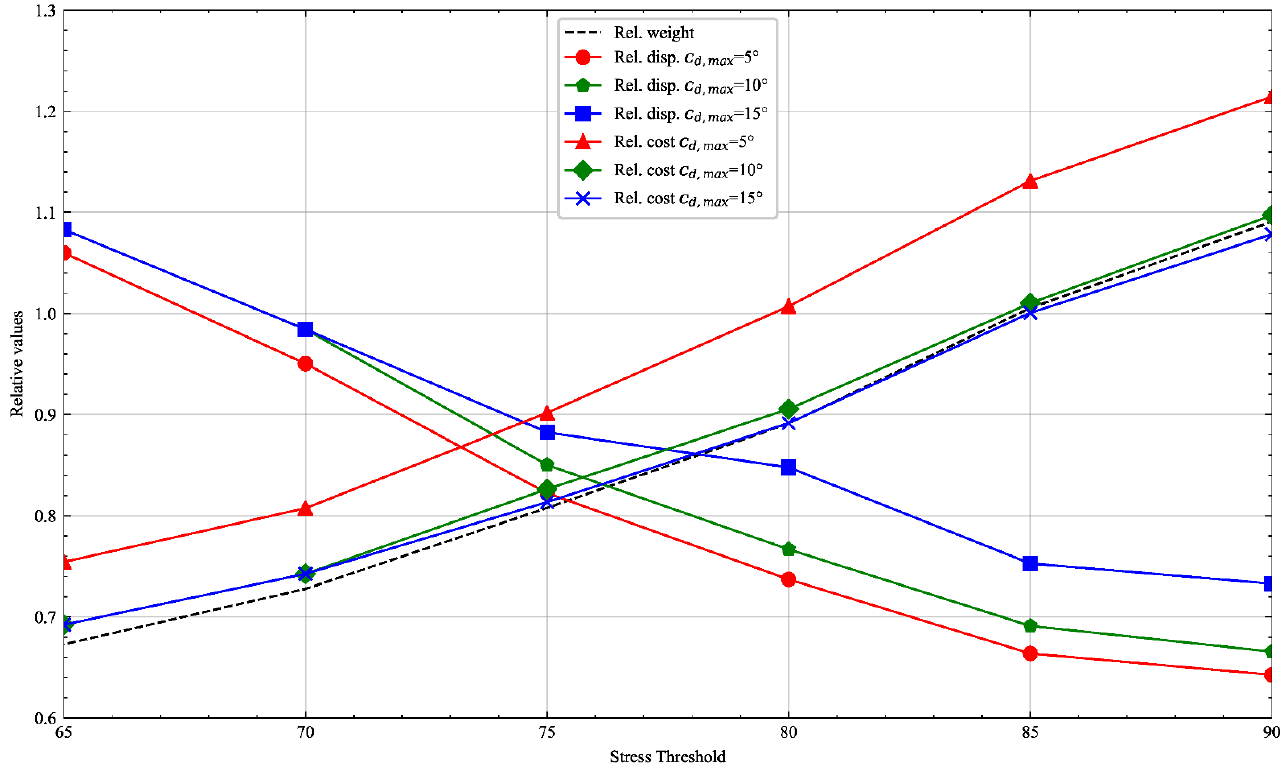
Figure 12. Relative cost, weight, and displacement for deviation factors of 5 ◦ , 10 ◦ , and 15 ◦ in relation to the reference laminate. Values below 1 indicate an improvement. The weight is equal for each case since it is defined only by the stress threshold, and therefore is independent from the deviation factor.